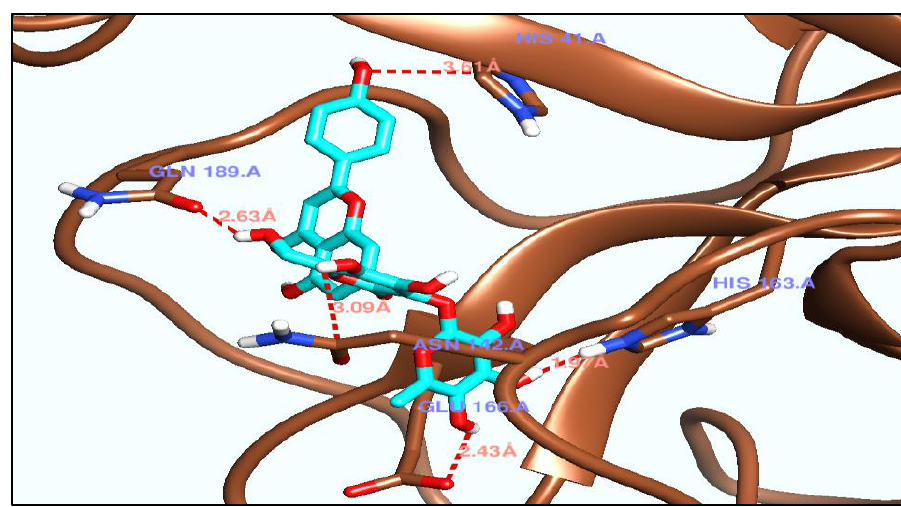
Figure 3 . Molecular docking of naringin has interacted with COVID-19 main protease